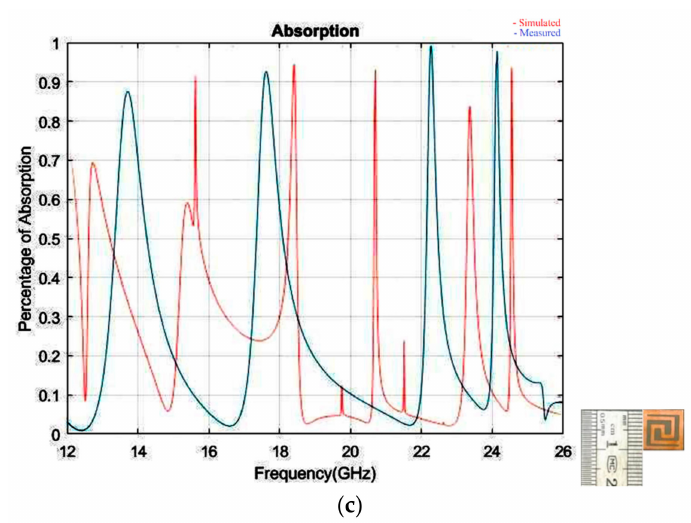
Figure 6. Simulated and measured results for Rogers RT 3035 and 6 × 6 ground ( a ) permittivity vs. frequency graph, ( b ) permeability vs. frequency graph, ( c ) percentage of absorption vs. frequency graph.